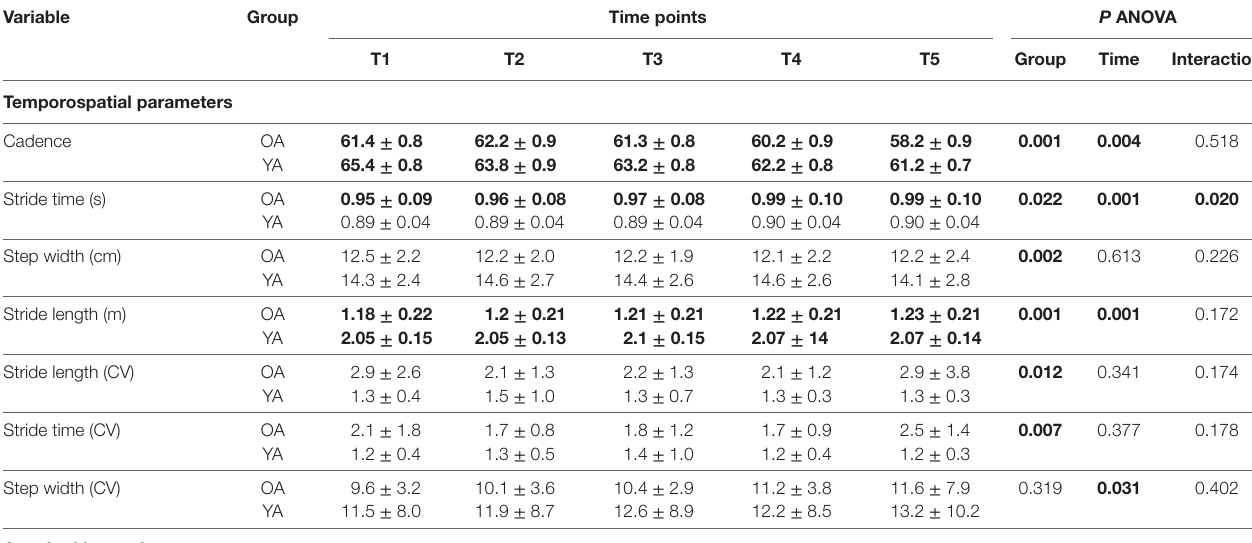
angular kinematics